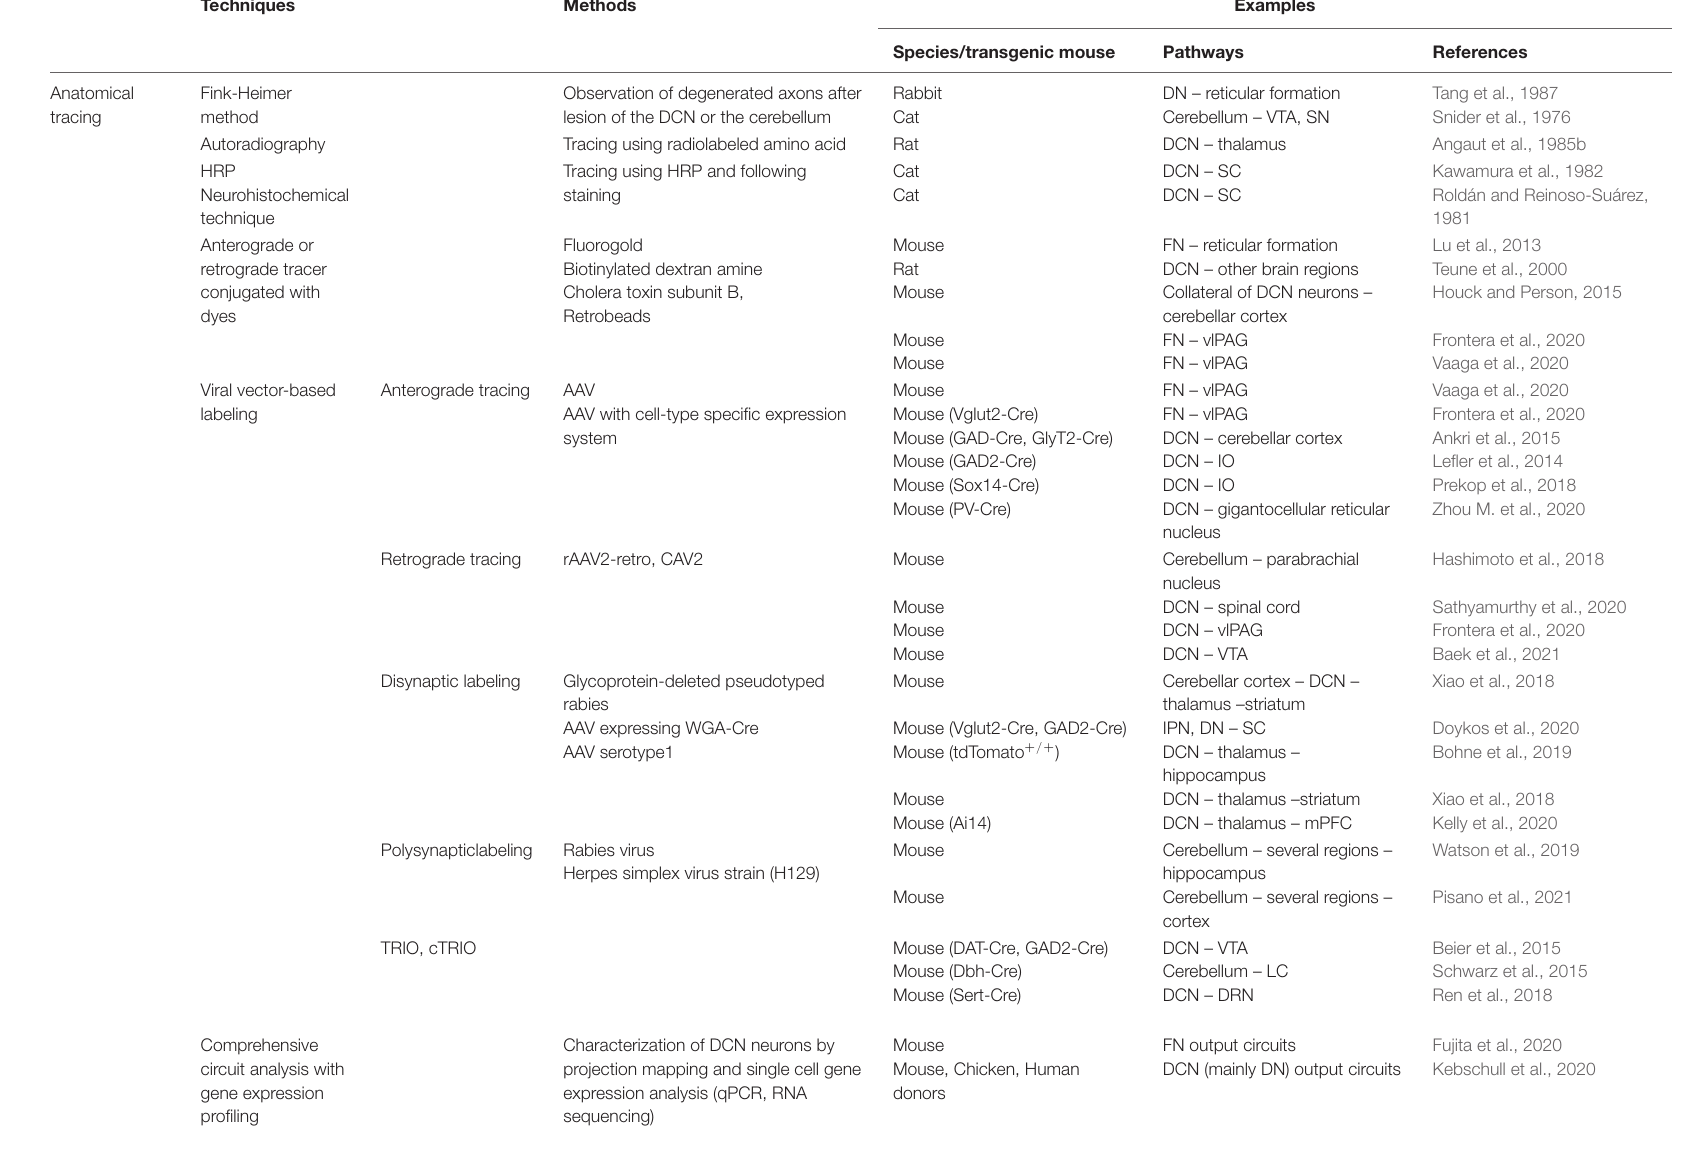
TABLE 2 | A summary of techniques that have been used for studies of cerebellar efferent